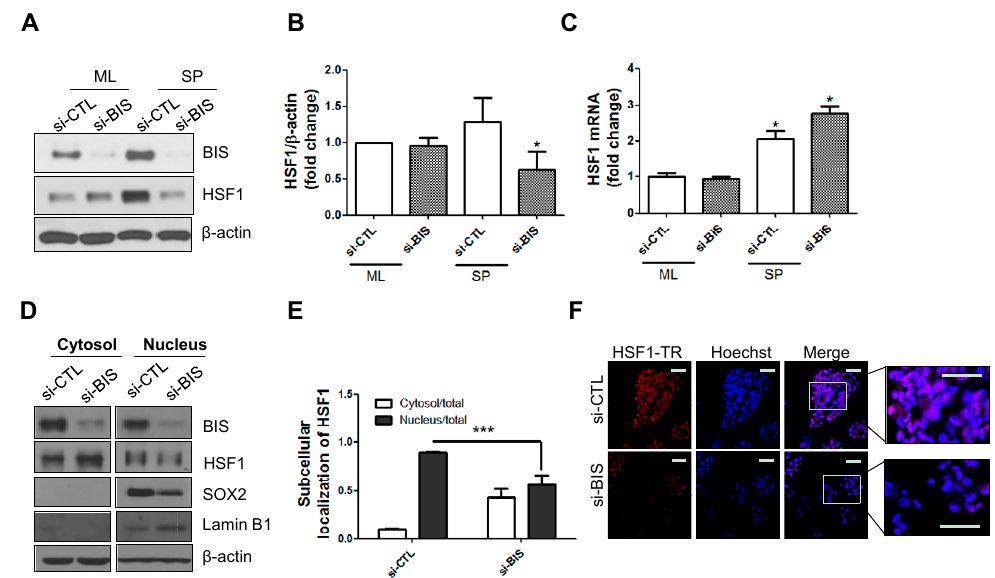
Figure 1. Bcl-2 interacting cell death suppressor (BIS) depletion decreased the protein, but not mRNA, levels of heat shock factor 1 (HSF1) in sphere (SP)-forming conditions. ( A , B ) Effect of BIS knockdown on HSF1 protein and ( C ) mRNA levels in A172 glioblastoma cells in standard monolayer (ML) and SP-forming culture conditions. Using small-interfering RNA for BIS (si-BIS), BIS expression was suppressed and then expression of HSF1 was analyzed by Western blotting and qRT-PCR. ( * p < 0.05 vs. the siRNA control (si-CTL) treated group in ML); ( D ) Subcellular localization of HSF1 in the SP-forming condition was analyzed by subcellular fractionation and subsequent Western blotting; ( E ) Quantification of HSF1 levels in nuclear and cytosolic fraction was carried out with Image J software after normalization with Lamin B1 and β -actin for nuclear and cytosolic HSF1, respectively. The relative distribution of HSF1 after BIS depletion in nuclear and cytosolic fraction was determined from three independent experiments. *** p < 0.005 vs. si-CTL; ( F ) HSF1 was labeled with Texas Red (TR) in spheres of A172 cells and examined by confocal microscopy. Hoechst 33342 was utilized for nuclear staining. Scale bar: 50 μ m.